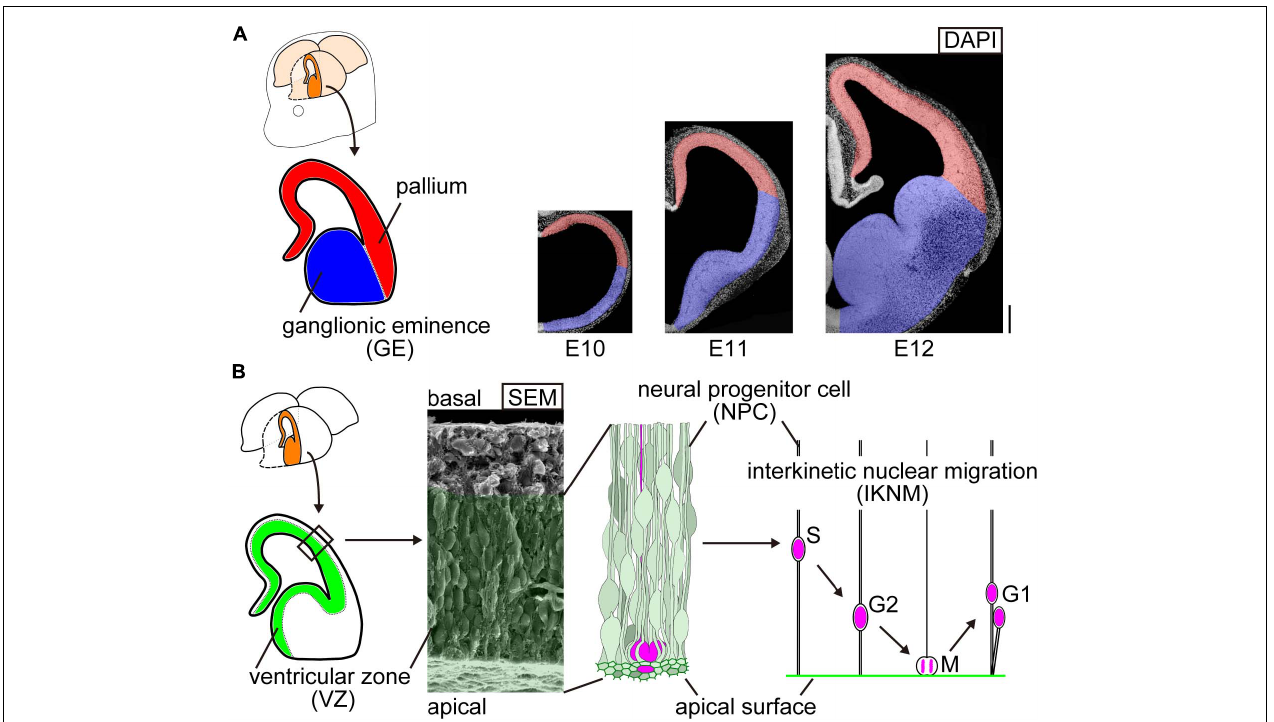
FIGURE 1 | Schematic representation of the embryonic mouse cerebral wall. (A) Two morphologically distinct neighboring regions in the developing mouse cerebrum: the pallium (red, concave at the inner or apical surface) and the ganglionic eminence (GE) (blue, apically convex). Cerebral walls are all apically concave at embryonic day (E) 10, and convexity arises only in the GE domain by E12. Scale bar, 200 µ m. (B) Composition and behavior of cells in the inner zone of cerebral walls. Elongated neural progenitor cells (NPCs) are tangentially assembled to form a wall. Their innermost (apical) portion is associated with each other via adherence junction. NPCs systematically move their nuclei and somata in a cell cycle-dependent manner: apical migration during G2 phase, followed by mitosis at the apical surface and further departure of daughter cells toward the basal side during G1 phase (called interkinetic nuclear migration, IKNM). The range of IKNM is histologically called the ventricular zone (VZ), which is filled with NPCs’ and their daughter cells’ nuclei/somata, as illustrated and shown in the scanning electron microscopy (SEM)